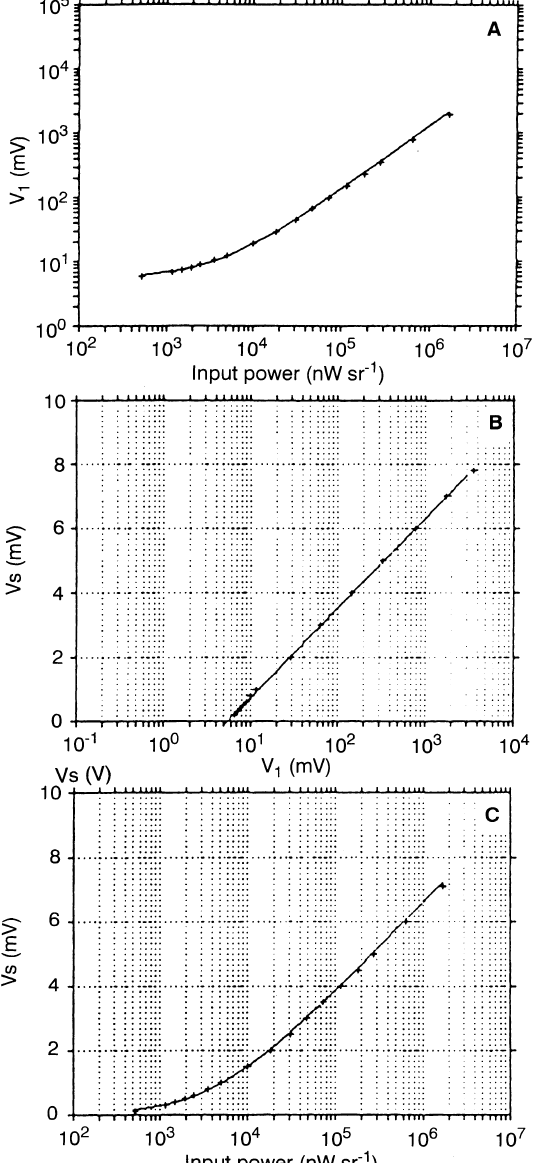
Fig. 11A–C. Results of the calibration of detector 12 ( (cid:104) equipped with lens system. A Transfer function of the transimpedance amplifier. B Transfer function of the logarithmic amplifier. C Calibration curve of the considered detector